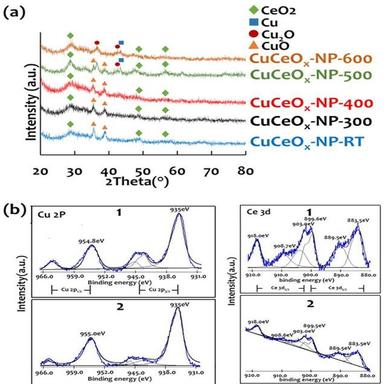
Analyses of crystallinity and surface state of the synthesized CuOx-CeO2 hybrid NPs (via aerosol spray method) with different temperatures of H2-reduction (Td2) using XRD and XPS. (a) XRD patterns. (b) XPS spectra of Cu 2p and Ce 3d regions. 1: CuCeOx -NP-RT. 2: CuCeOx-NP-600. Reprinted with permission from Ref..